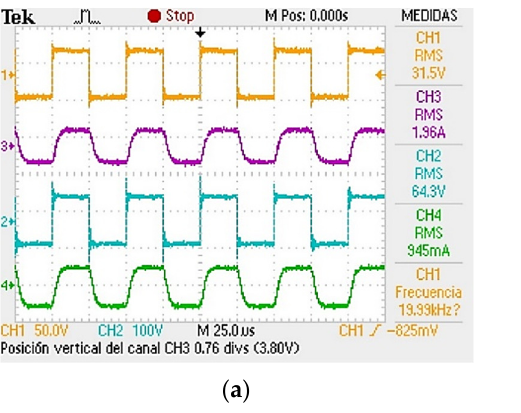
Figure 12. MFT input and output voltages and currents (6% P nom ): ( a ) Nanocrystalline, ( b ) Ferrite.